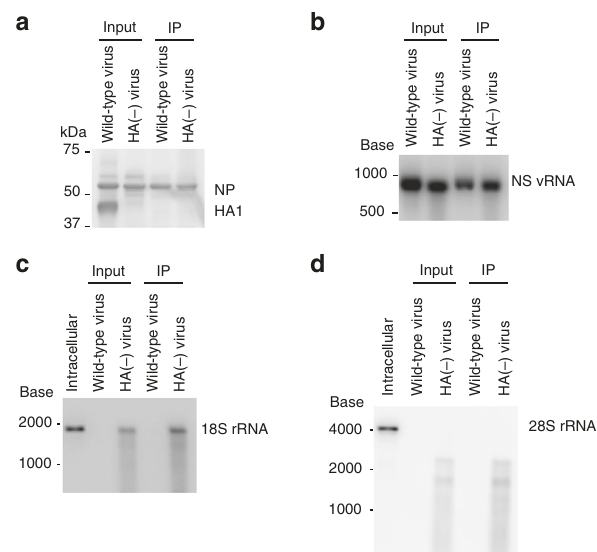
Fig. 5 Co-immunoprecipitation of 18S and 28S rRNA with the NP protein. Puri fi ed virions were disrupted in buffer containing TritonX-100, incubated with an anti-NP antibody, and precipitated with Protein G beads. a The precipitates were subjected to western blot analysis using an anti-whole virion polyclonal antibody. b – d RNAs were extracted from the precipitate and were subjected to northern blotting by using riboprobes speci fi c for